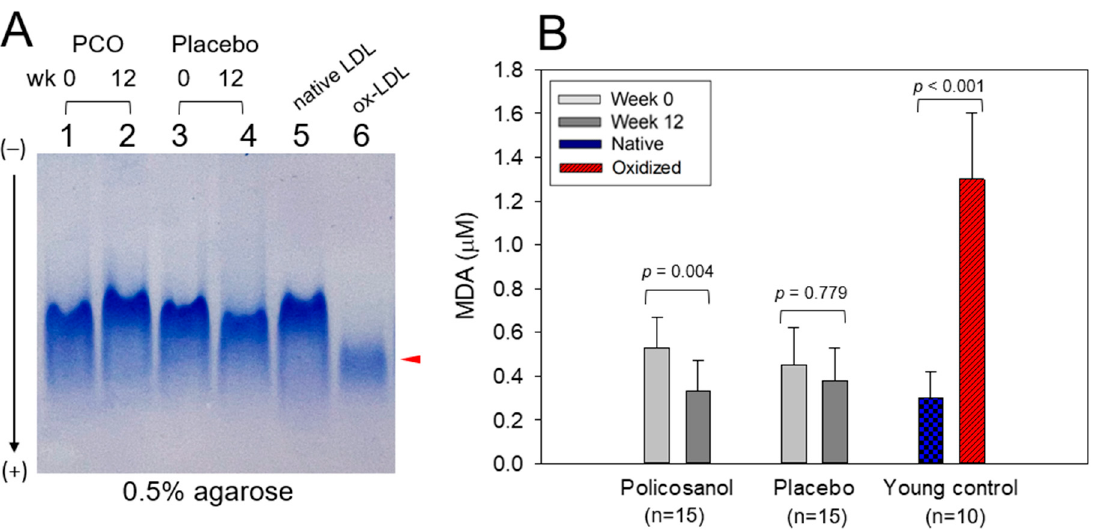
Figure 4. Comparison of the electromobility ( A ) and quantification of oxidation extent ( B ) in LDL from the policosanol (PCO, 20 mg) group and placebo group between weeks 0 and 12. ( A ) Electrophoresis under the nondenatured state on 0.5% agarose gel (120 mm length × 60 mm width × 5 mm thickness). Electrophoresis was carried out with 50 V for 1 h in Tris-acetate-ethylene-diamine-tetraacetic acid buffer (pH 8.0). The red arrowhead indicates an oxidized LDL band. The apo-B in LDL was visualized by Coomassie brilliant blue staining (final 1.25%). Lane N, native LDL (1.0 mg/mL of protein), which was purified from a young and healthy control. Lane O, oxidized LDL, cupric ion (final 1 µ M) treated for 4 h; PCO, policosanol. ( B ) Quantification of the oxidized LDL contents by a thiobarbituric acid reactive substance assay using a malondialdehyde (MDA) standard. The data are expressed as mean ± SEM from three independent experiments with duplicate samples. In the young control, cupric ion (final 10 µ M) treated LDL (O) was compared with native LDL alone (N) using a paired t -test. The oxidation extent in each group between weeks 0 and 12 was compared by the paired t -test.